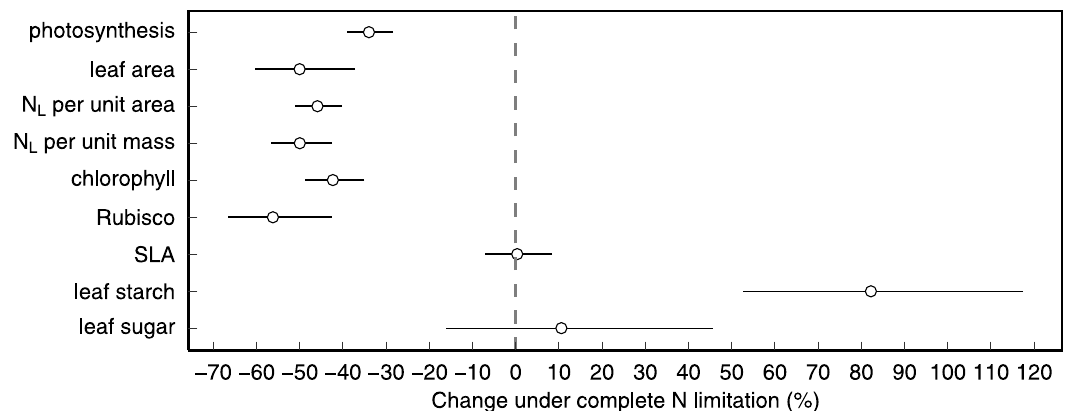
Fig 2. Effect of maximum N limitation on photosynthetic response variables. Estimated effects of experimental N limitation at maximum N limitation (i.e., zero nitrogen addition in the N limitation treatment) on photosynthetic response variables. Points show modelled estimates and whiskers represent 95% confidence interval. Sample sizes (number of studies, number of experiments) differ between variables: photosynthetic rate (50, 182), leaf area (21, 80), N L per unit area (23, 120), N L per unit mass (17, 95), chlorophyll content (32, 116), Rubisco content (13, 50), SLA (15, 68), leaf starch (8, 25), leaf sugars (12, 57). Leaf starch and leaf sugar includes measurements on both area and mass basis. Chlorophyll content represents mostly per unit area measurements but contains a small fraction of mass basis measurements (13%).